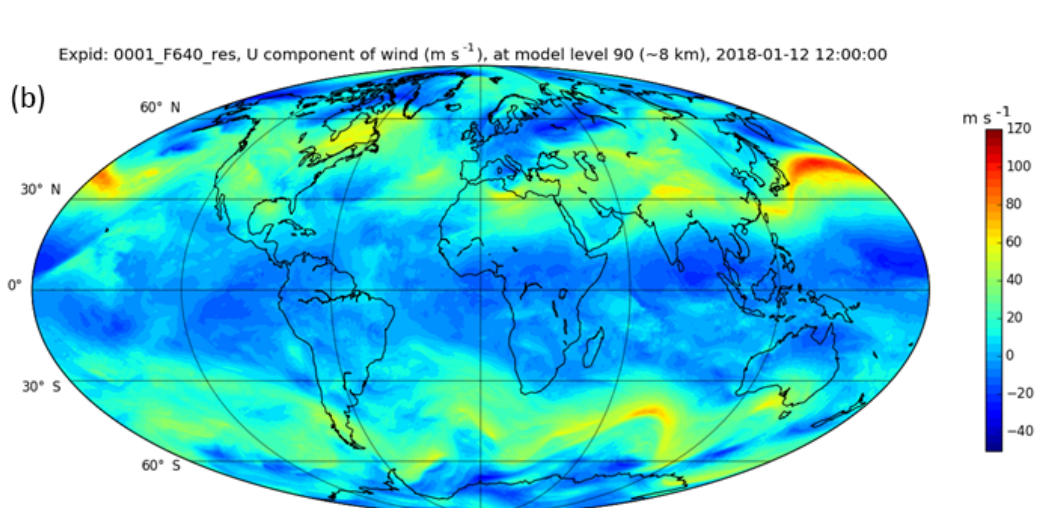
Figure 1. Cloud ice water content (a) and ECMWF zonal winds (b) at a height of 8km at noon on 2 January 2018. The data are plotted at a resolution of about 14km. Ice water is only plotted when the mixing ratio exceeds 10 − 6 kgkg − 1 or ∼ 2 × 10 − 3 gm − 3 or a reflectivity of ∼ − 23dBZ (Hogan et al., 2006). Plot courtesy of Michael Rennie,